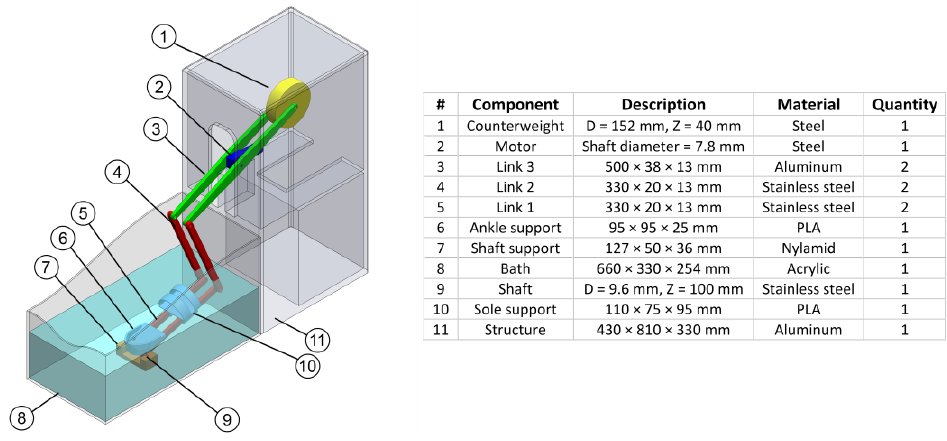
Figure 2. Robot design.